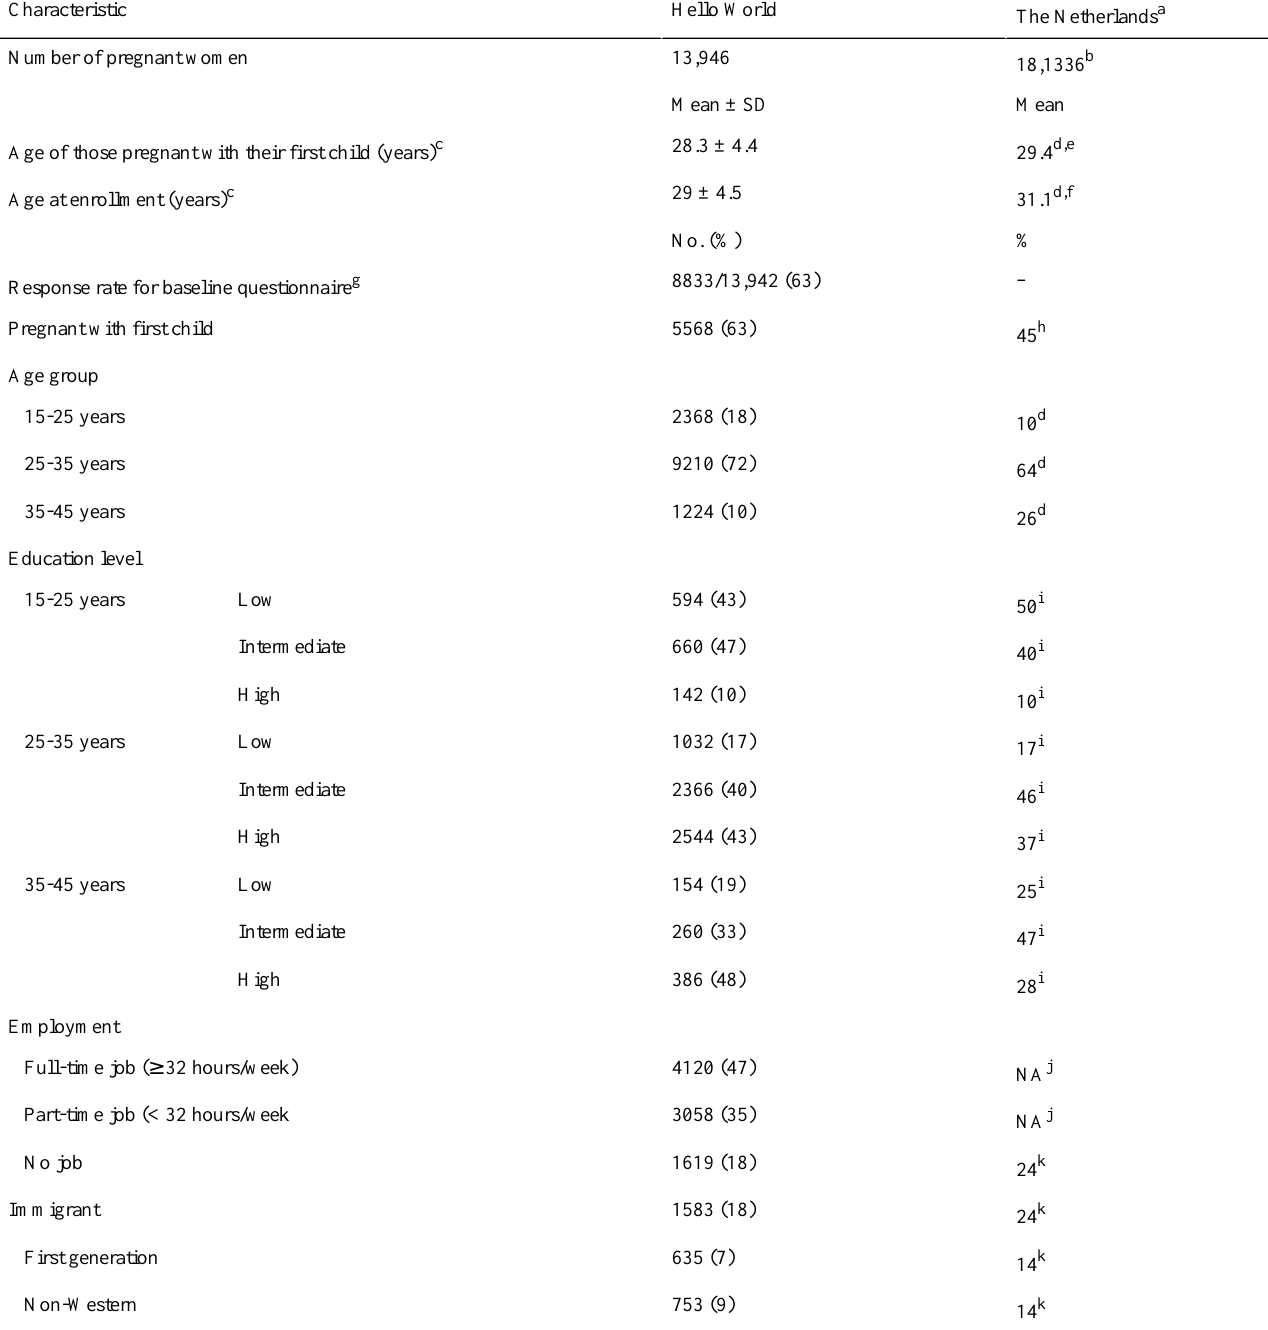
Table 1. Characteristics of the participants of Hello World